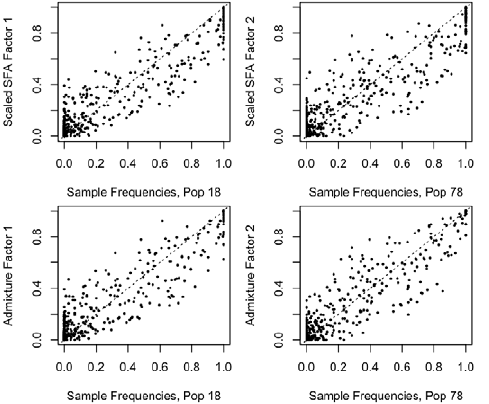
Figure 5. Estimated scaled factors from SFA and ADMIXTURE on the 1-D isolation-by-distance simulation against the generating allele frequencies. In each plot the factors ( y -axis) are plotted against the population allele frequencies for the closest-matching population. The SFA factors were truncated to have a minimum of zero and scaled to have a maximum of one. The dashed diagonal line shows y ~ x